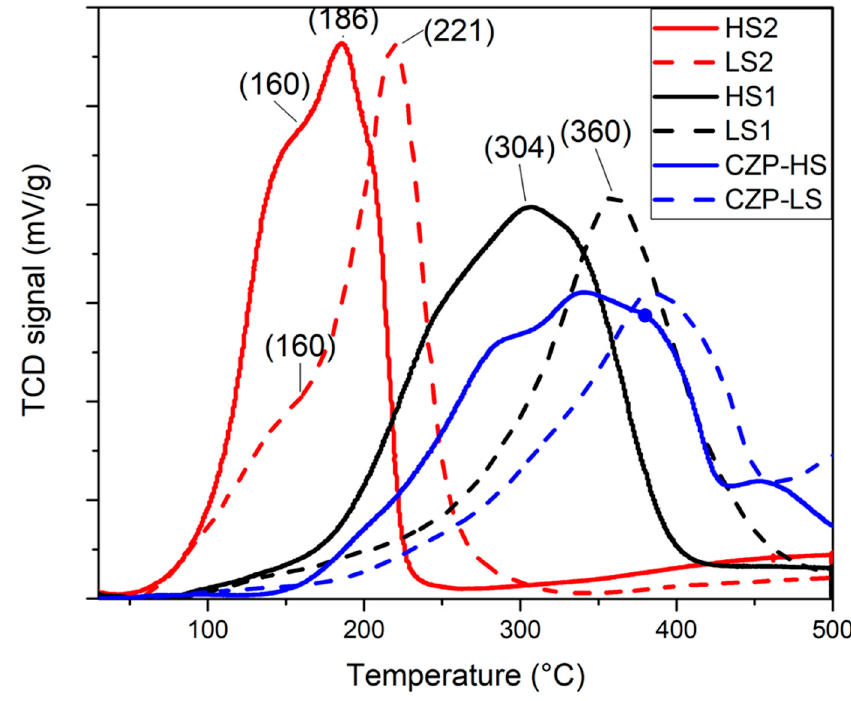
Figure 3. H 2 -TPR profiles for Pd-HS, Pd-LS and their bare CZP45 supports. Table 2. H 2 consumption during H 2 -TPR and Pr 4+ /Pr 3+